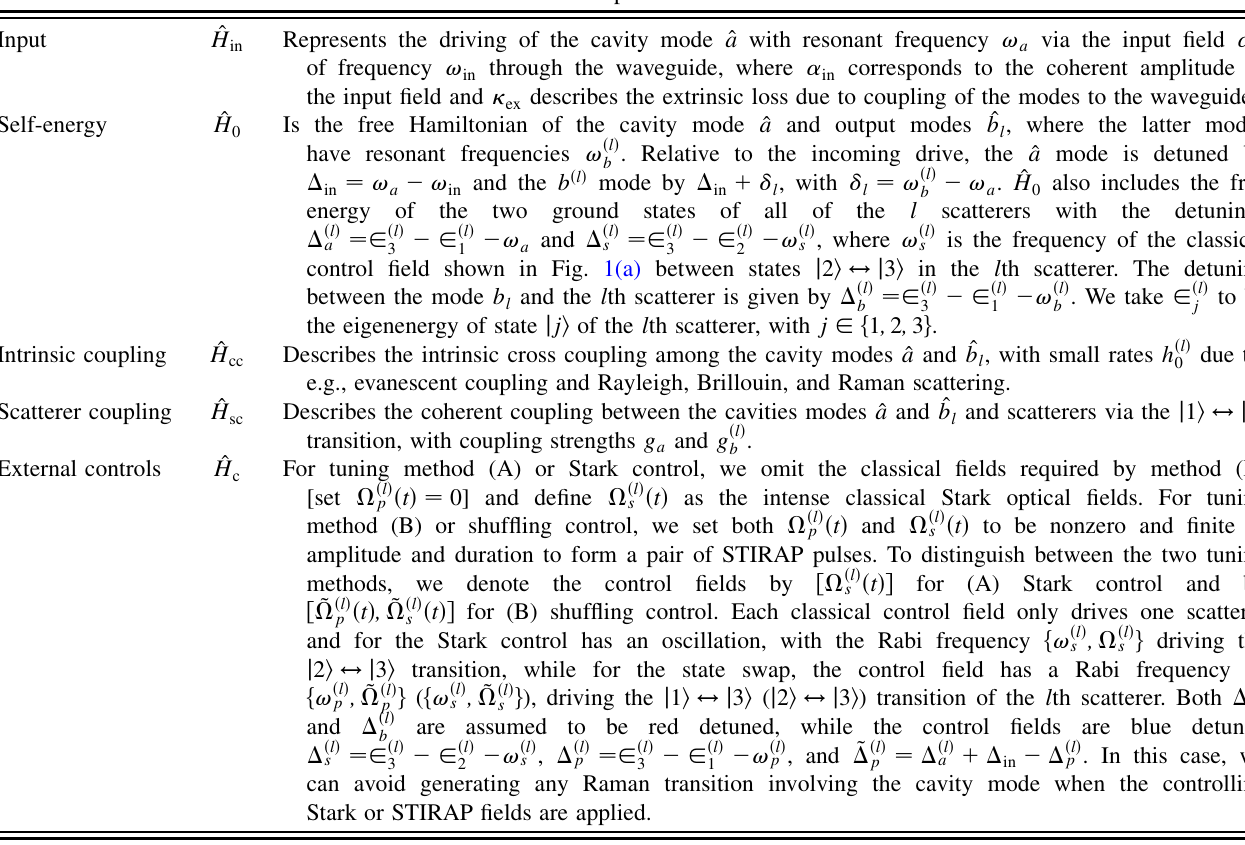
TABLE I. Description of